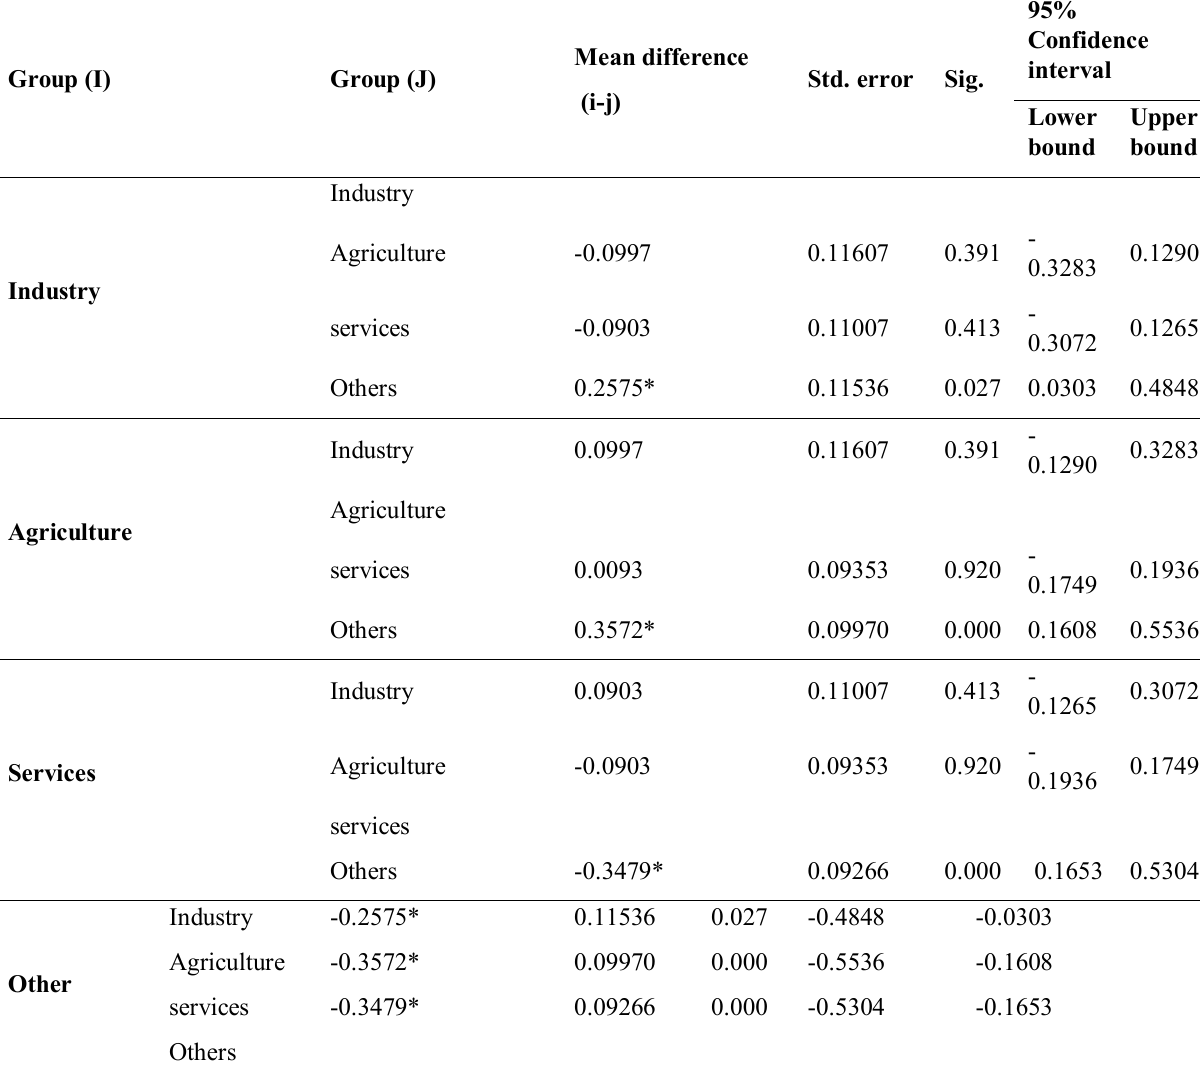
Table 17-Multiple comparison of different sectors` ROA at high investment quartiles